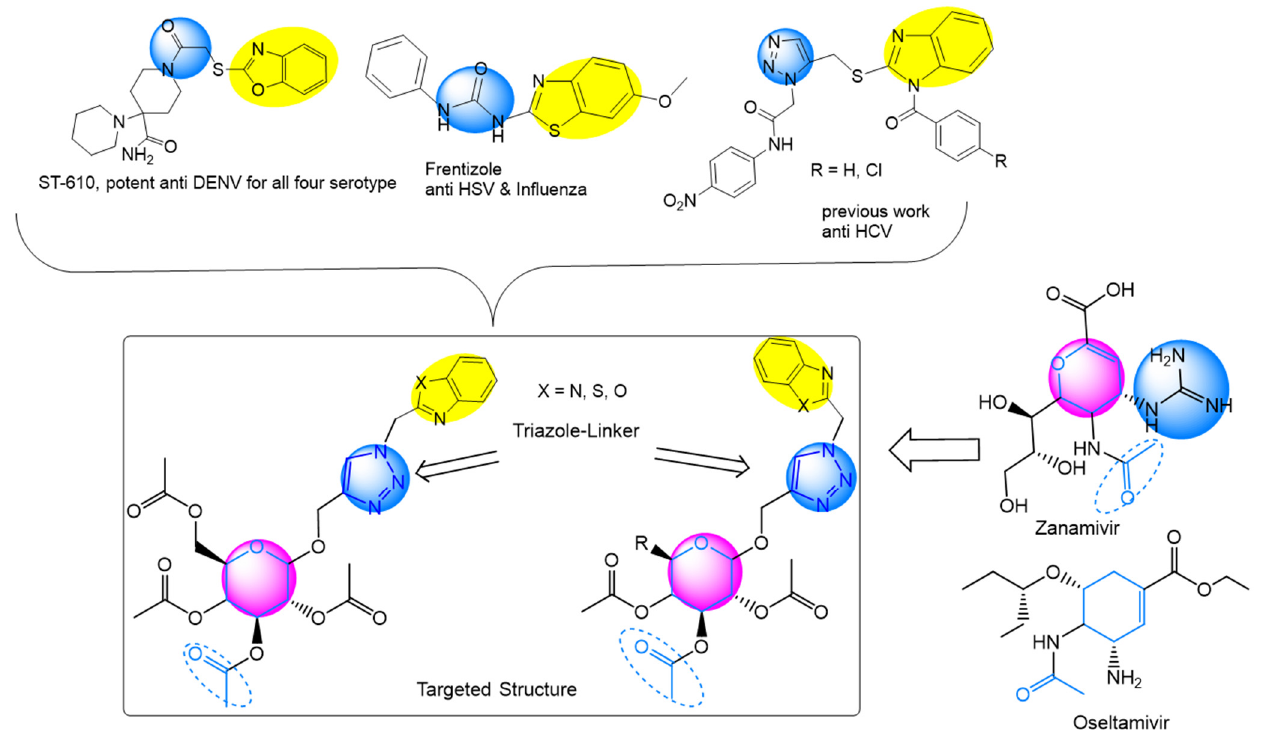
Figure 1. Medicinal chemistry rational and structures of zanamivir, oseltamivir, and selected anti- viral candidates.